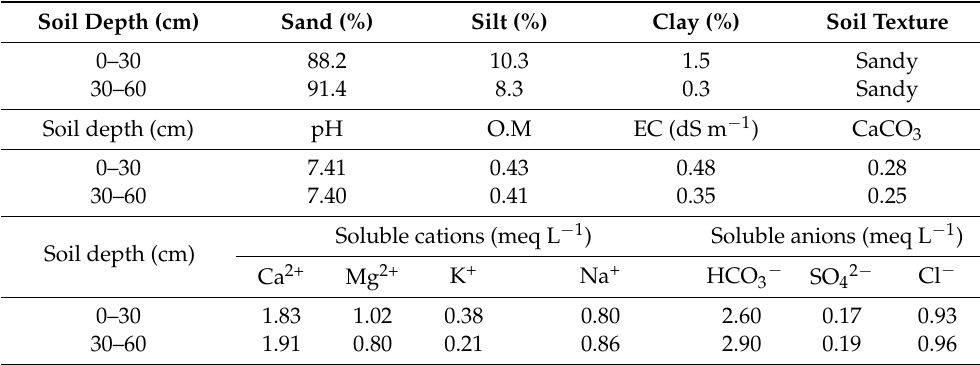
Table 1. Average physicochemical soil parameters of the experimental site in both 2019 and 2020 seasons. Soil Depth